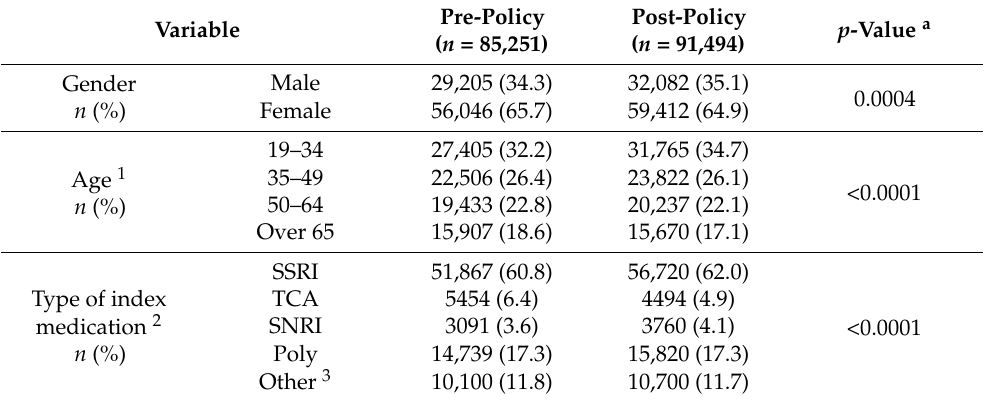
Table 1. Demographic characteristics of patients diagnosed with depression by payment scheme. Variable